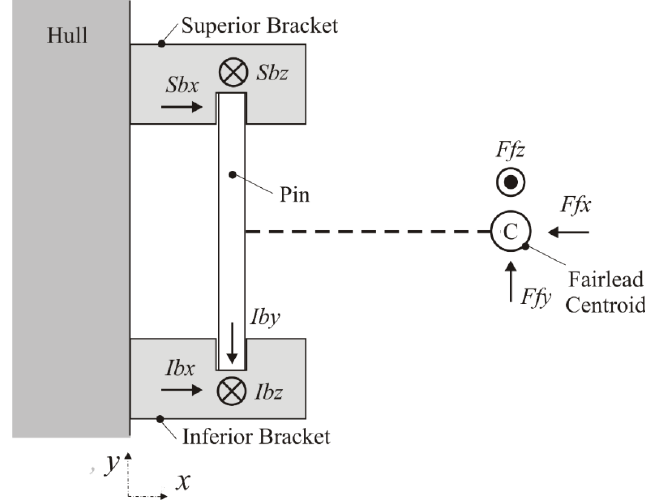
Table 3. Characteristics of the mooring lines and loads of the line applied in the fairlead centroid.